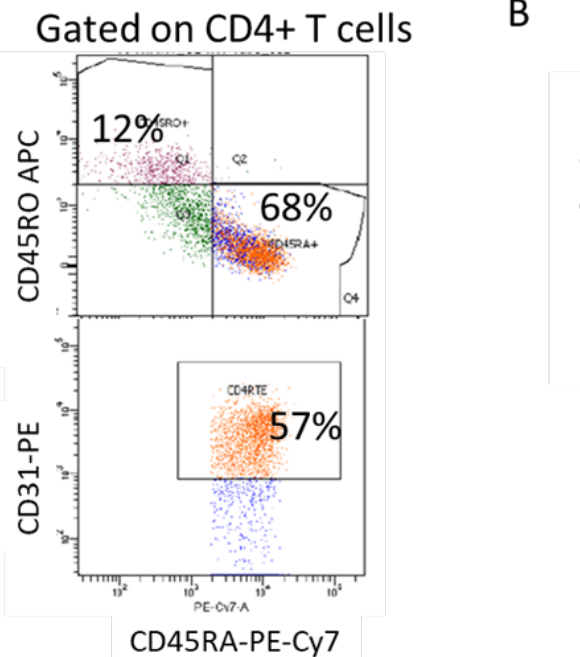
Figure 3. Case 1, phenotype and functional assessment of lymphocyte populations. ( a ) Relative percentages of naïve (CD45RA+) and memory (CD45RO+) T cells, and recent thymic emigrant (CD45RA+CD31+) T cells; ( b ) Proliferation of CD45+ lymphocytes and CD3+ T cells in response to phytohemagglutinin (PHA) stimulation. Peripheral blood mononuclear cells were stimulated with PHA for 72 h. The cells were incubated with a modified nucleoside (5-Ethynyl-2′-deoxyuridine) and then labeled with a fluorescent dye. Proliferating cells (CD45+ lymphocytes and CD3+ T cells) were identified by an increase in fluorescence.